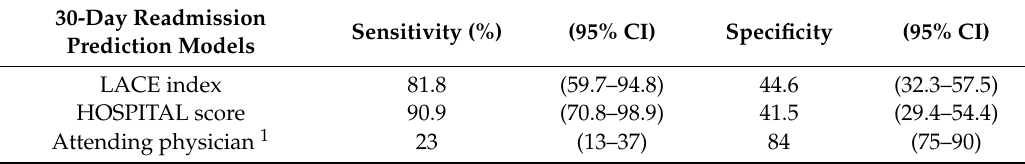
Table A1. Summary of parameters used in the microsimulation model to evaluate the 30-day readmission rate reduction and cost of preventive intervention by the LACE index, HOSPITAL score, and attending physician prediction models.